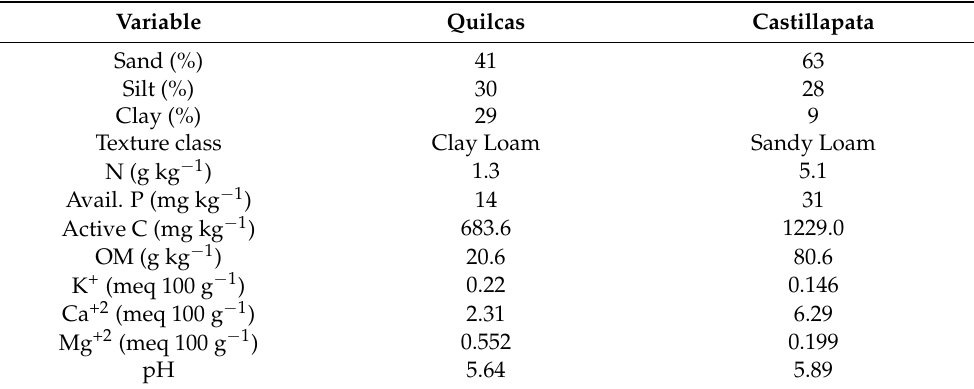
Table 1. Physical and chemical properties of soils used in pot experiment. Soils were collected from two localities in Peru (Castillapata, Huancavelica Region and Quilcas, Jun í n Region). Variable Quilcas Castillapata